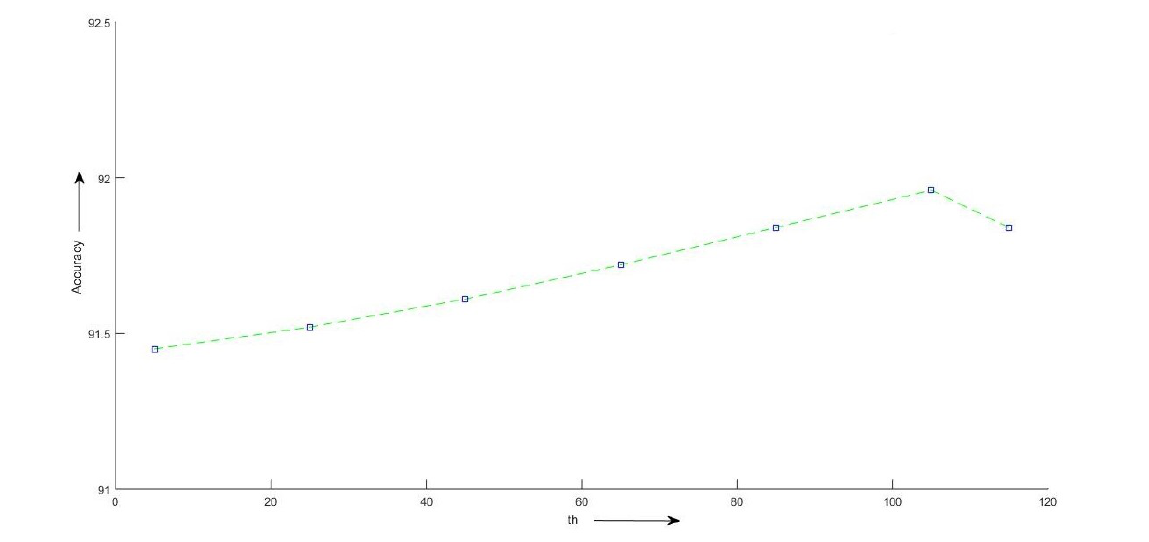
Figure 11. Graphical comparison of the performances of RULBP with different threshold in classifying the texts and non-texts present in handwritten document